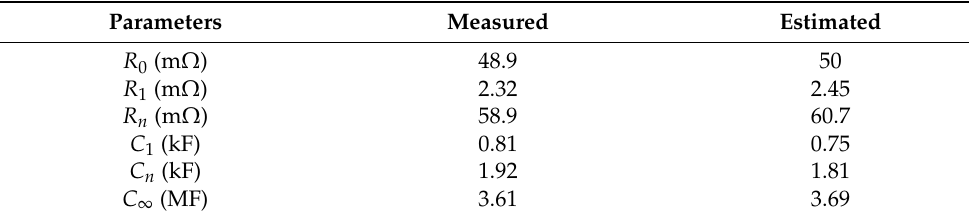
Table 14. Results of Case 7.